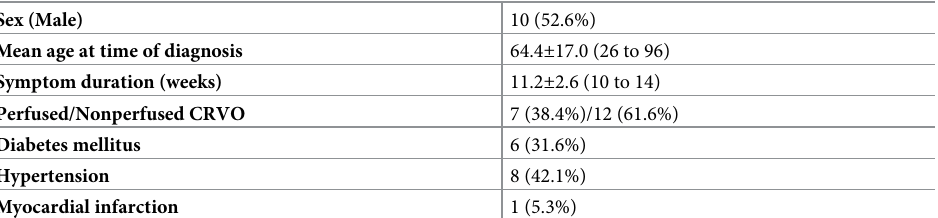
Table 1. Baseline characteristics of enrolled patients with unilateral